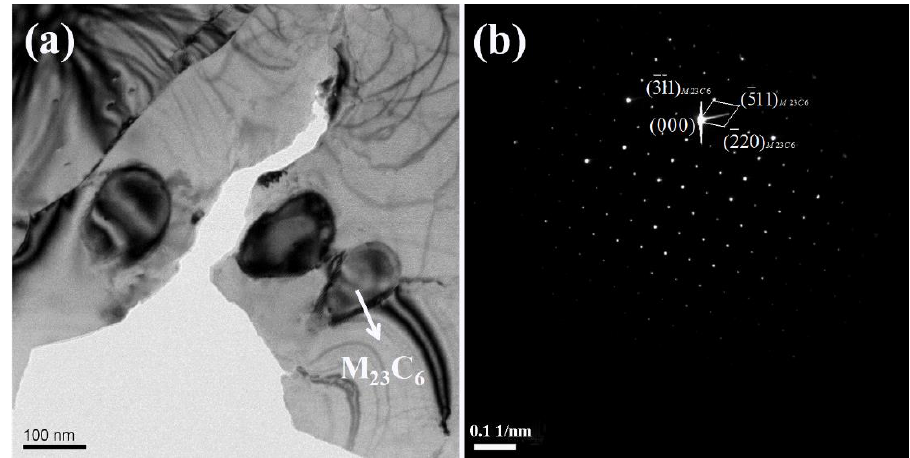
Figure 7. TEM Characterization of M 23 C 6 phase in the DSS 2002 specimen with a cooling rate of 0.25 °C/s: ( a ) a bright-field image; ( b ) diffraction pattern.